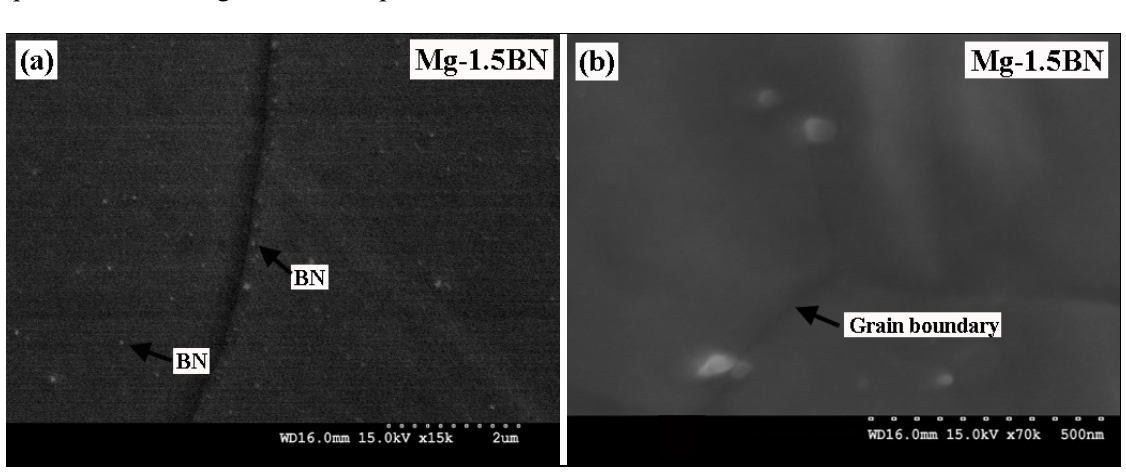
Figure 2. Representative SEM micrographs showing ( a ) the distribution of nano-boron nitride (BN) particulates; and ( b ) the interface between Mg-matrix and the nano-BN particulates in Mg-1.5BN